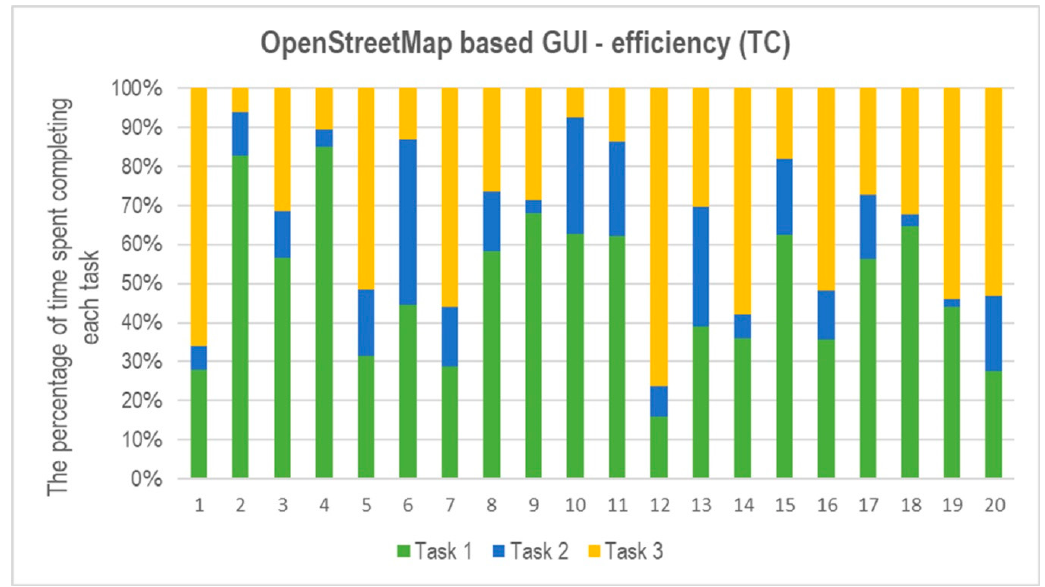
Figure 6. The percentage of time needed for completing tasks (TC) by each participant on OpenStreetMap-based GUI.